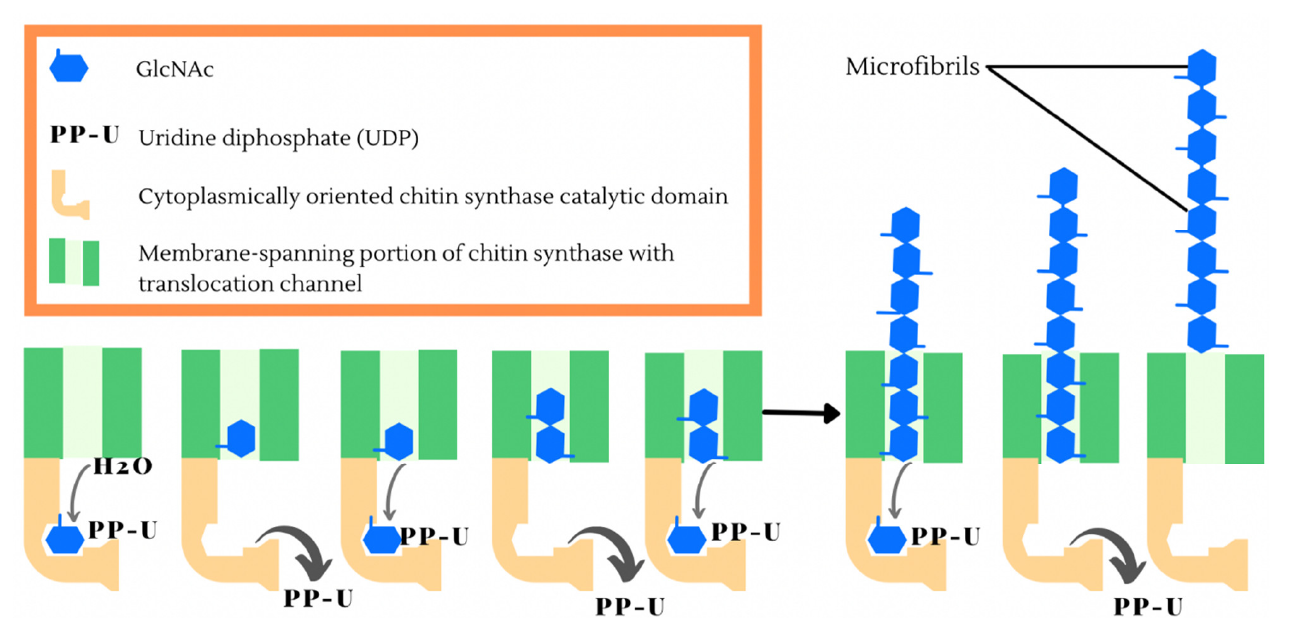
Figure 4. Schematic representation of N-acetyl-glucosamine formation into the chitin polymers.